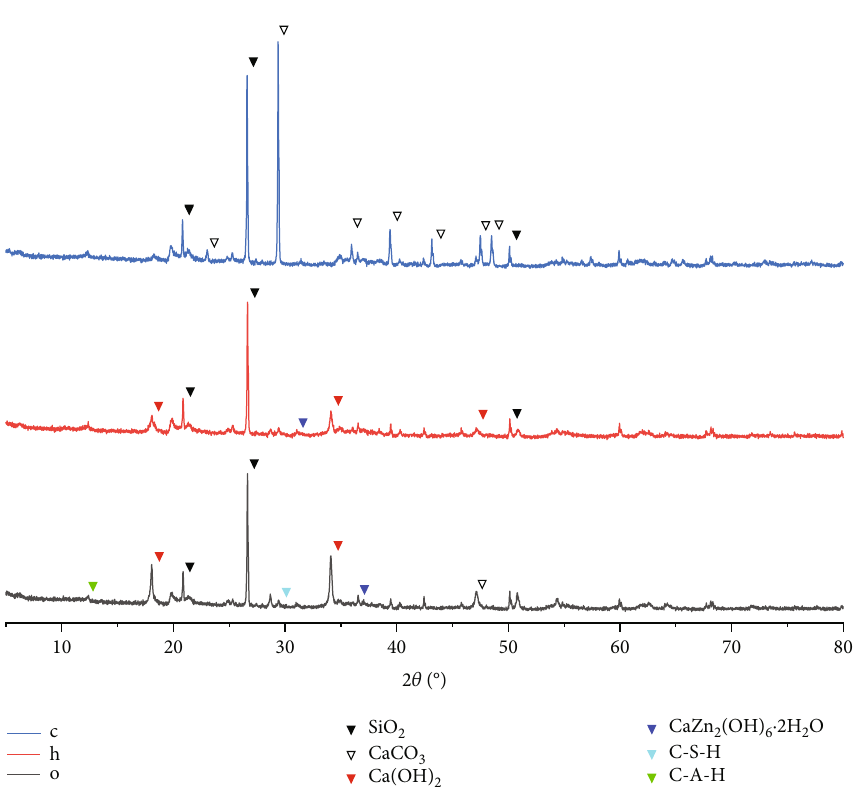
Figure 5: XRD patterns of zinc-contaminated red clay cured by di ff erent curing